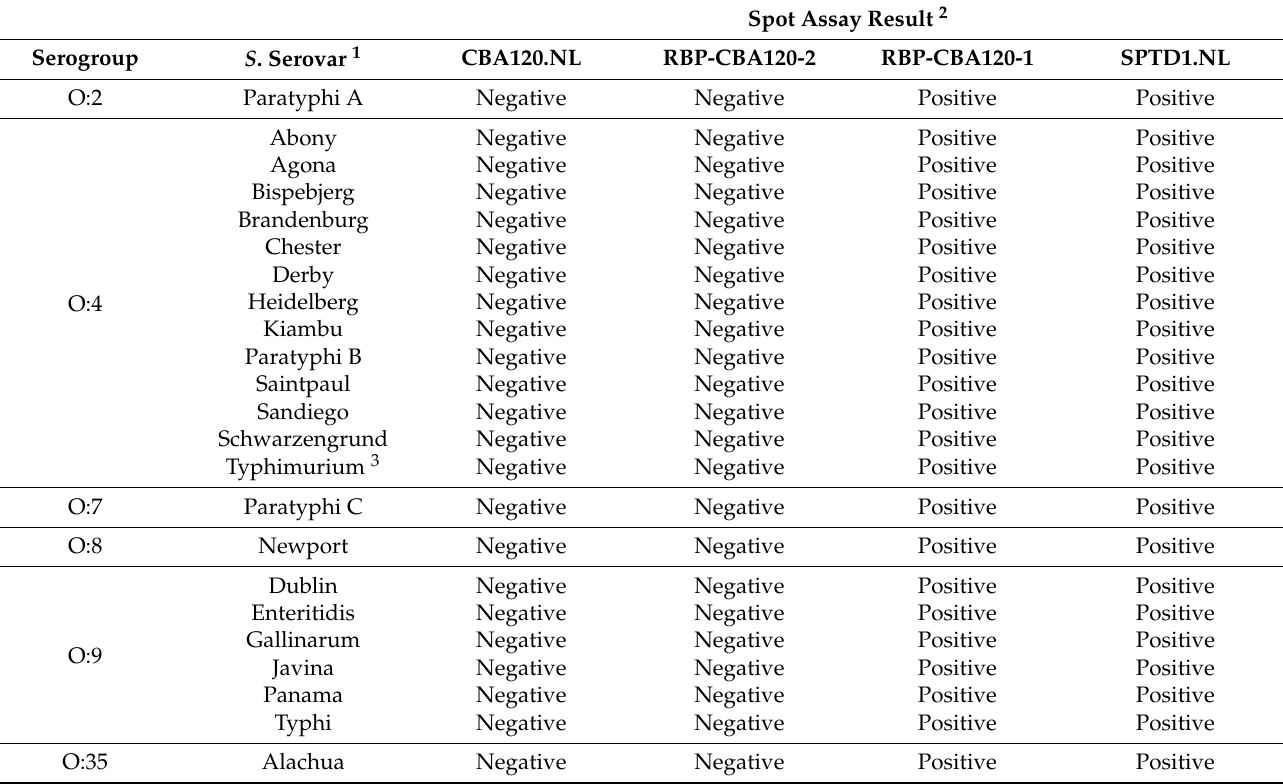
Table 2. Activity of CBA120.NL with Native or Chimeric TSPs on Salmonella Serovars Targeted by